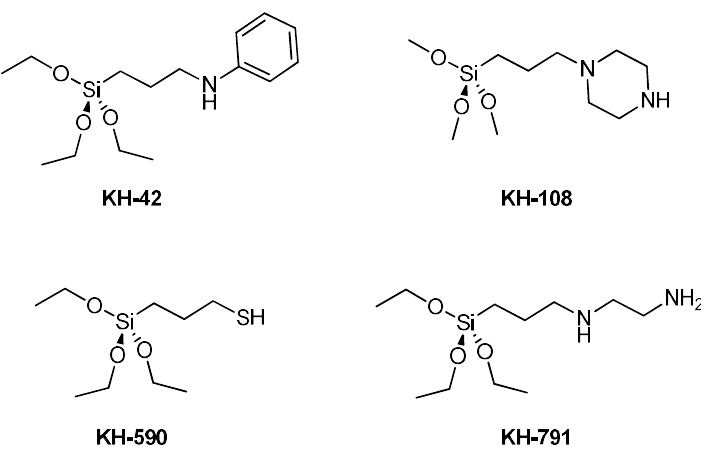
Figure 23. Silanes used for the modification of HNTs for environmental purposes.